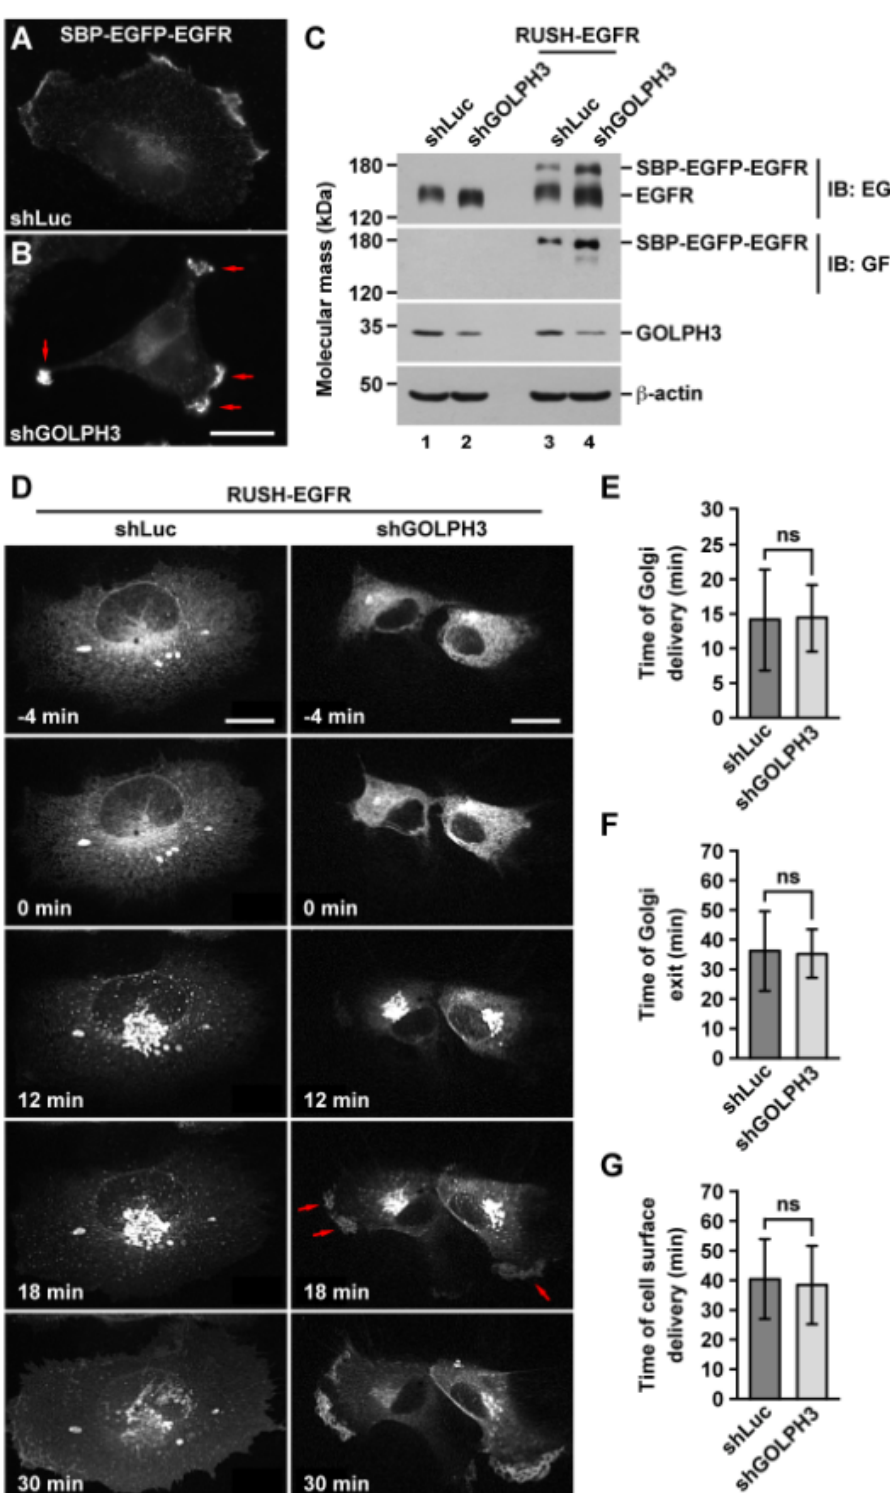
Figure 4. The knockdown of GOLPH3 does not affect the transport of EGFR to the cell surface in T98G cells. ( A , B ) The indicated cells grown in glass coverslips for 48 h were transiently transfected with a RUSH-EGFR construct that allows the expression of SBP-EGFP-EGFR and Str-KDEL. After 24 h, cells were incubated 1 h with 40 µM biotin for the release of SBP-EGFP-EGFR molecularly hooked to Str-KDEL at the endoplasmic reticulum. Cells were fixed and examined by fluorescence microscopy. Arrows depict cell protrusions. Bar, 10 µm. ( C ) The indicated cells grown in 6-well plates for 48 h were either mocked transfected (lanes 1 and 2) or transfected with the same RUSH-EGFR construct